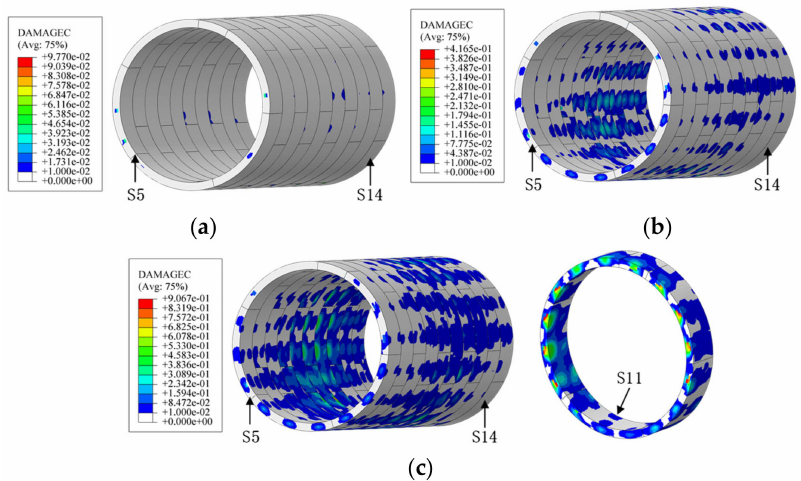
Figure 6. Tensile damage distribution of the segmental tunnel under normal fault dislocation: ( a ) un- der 5 cm fault displacement, ( b ) under 10 cm fault displacement, ( c ) under 15 cm fault displacement. Some like +3.484e-02 means 3.484 × 10 − 2 .